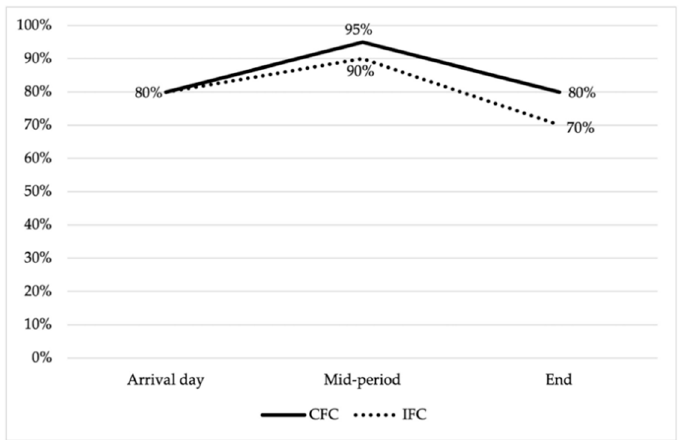
Figure 1. Antimicrobial resistant E. coli isolates dynamic for commercial (CFC) and improved farm conditions (IFC) throughout the growing period. No statistically significant differences were ob- served.